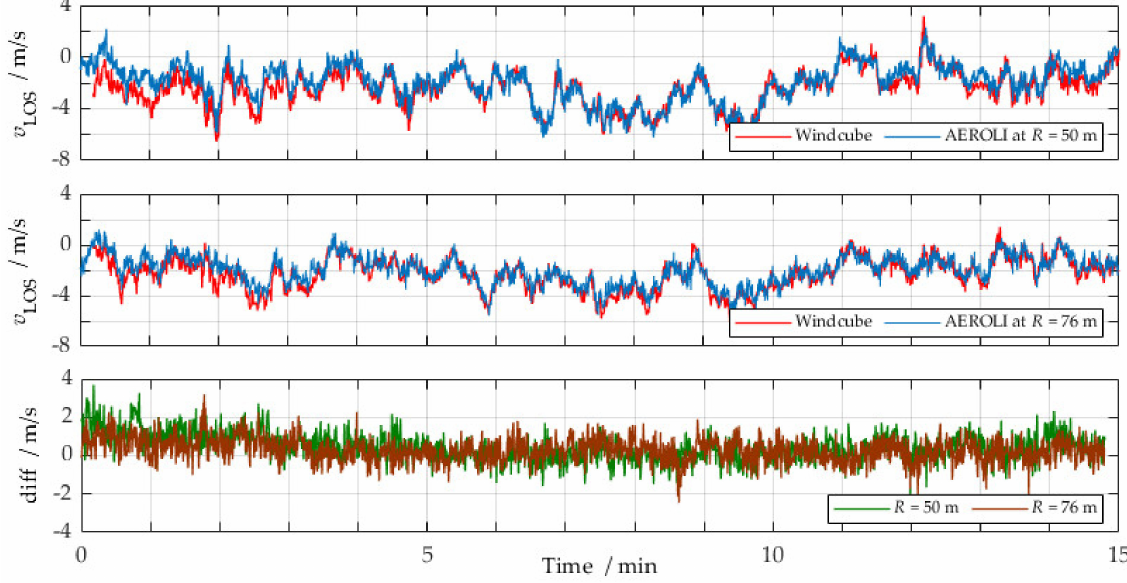
Figure 8. Wind measurement set taken on 29 January 2018, 19:19 h UTC. The upper two panels show the wind measurement by the Windcube ® and AEROLI, respectively. The offset bias of the latter has already been subtracted. The lower panel shows the difference in the above measurements, after re-interpolation on a common time frame. The standard deviations of the difference between the two wind lidars are 0.68 m/s at 50 m and 0.64 m/s at 76 distance, respectively.